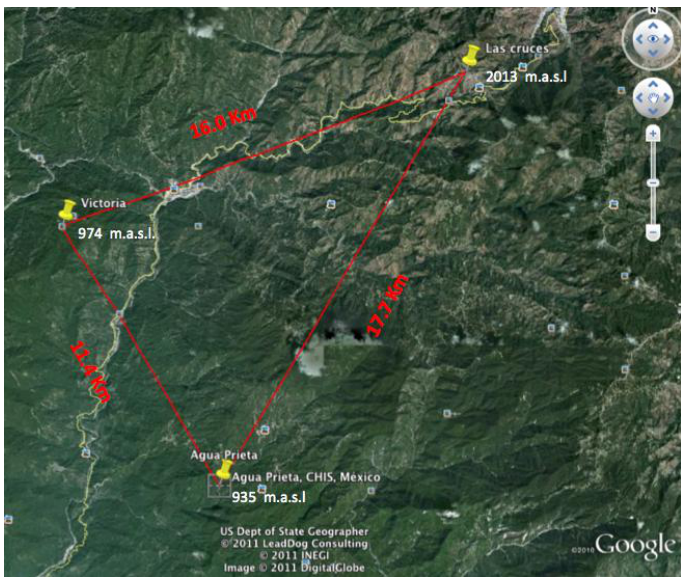
Figure 20. Distances measured between RTUs and BTU in Huixtla’s